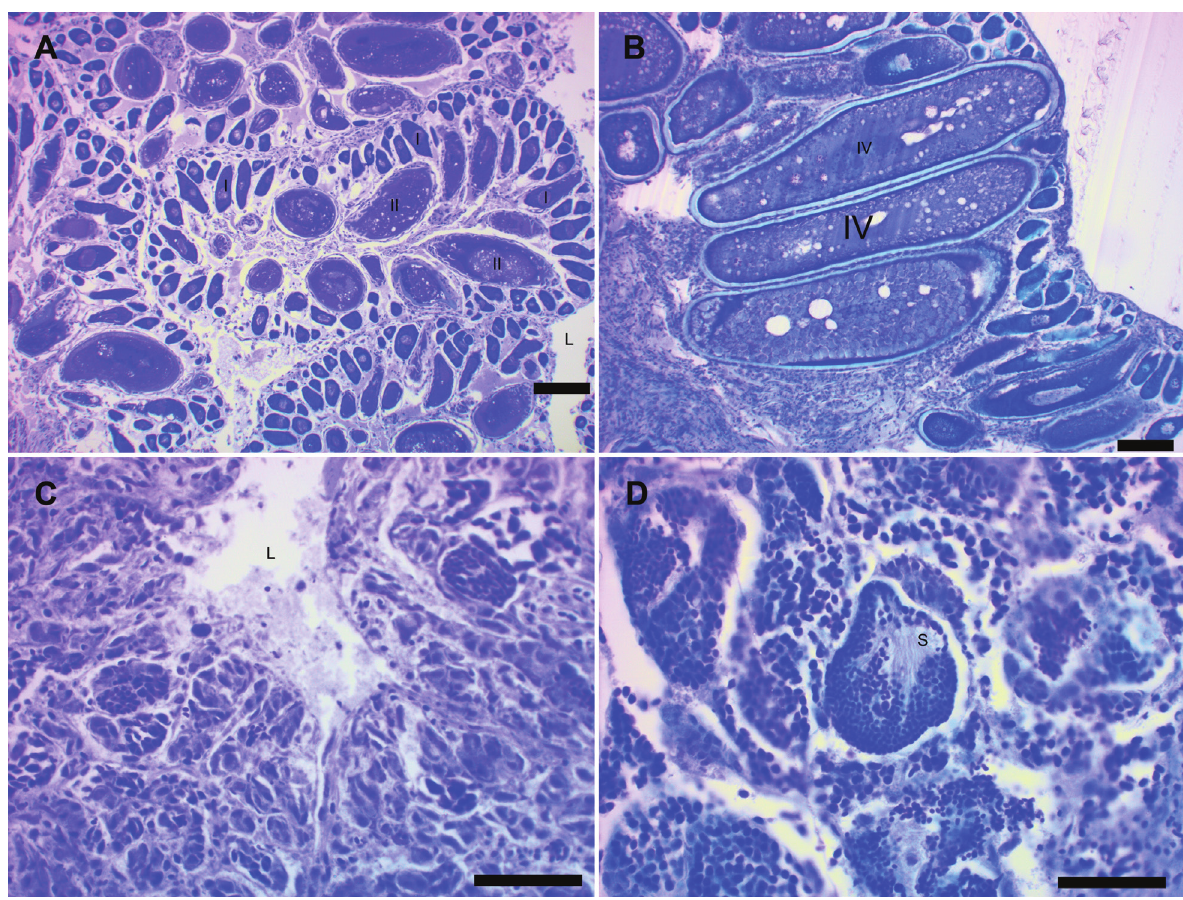
Figure 6. Histological sections of gonads of Chlorurus microrhinos from Fiji. ( A ) ovary of immature female (36.3 cm L taining primary-growth (I) and cortical vesicle (II) oocytes, plus a conspicuous lumen (L); ( B ) ovary of mature female (37.1 cm L containing a mixture of oocyte stages including final maturation (IV); ( C ) testis from an immature male (38.0 cm L tailed spermatozoa, but with a conspicuous lumen (L); ( D ) testis of a mature male (38.7 cm L bars = 100 μm ( A and B ) or 50 μm ( C and D ).